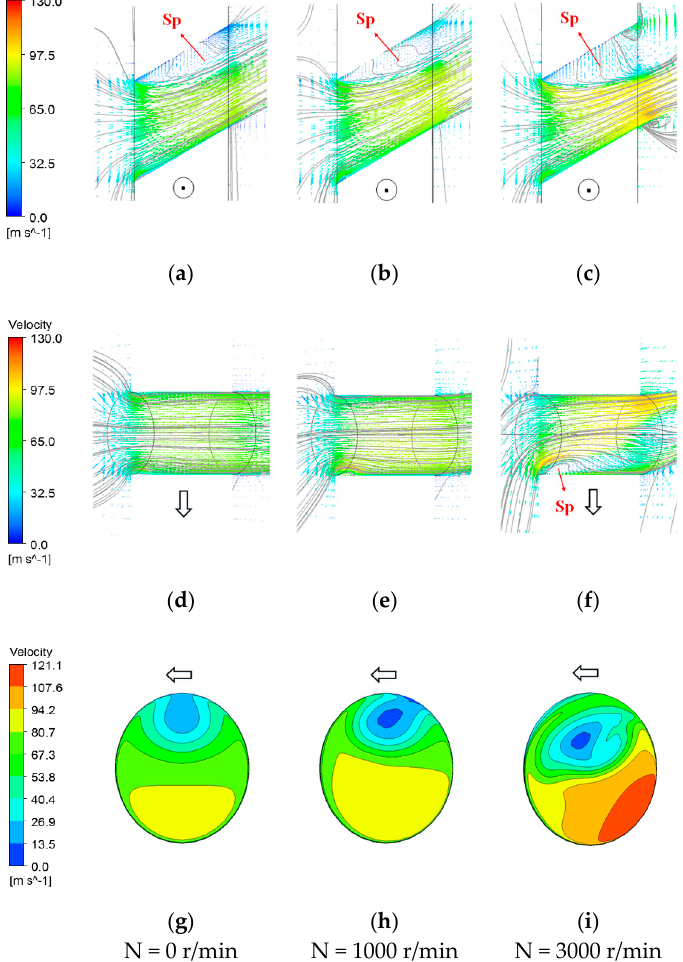
Figure 25. Streamlines and velocity contours of different sections ( 𝛼 (cid:2868) = 30°). ( a – c ) Meridian section; ( d – f ) circumferential cross-section; ( g – i ) velocity contour of the exit section. ( a , d , g ) 𝛼 (cid:2868) = 30°, i = − 26.7°, 𝐶 (cid:2914) = 0.732, ( b , e , h ) 𝛼 (cid:2868) = 30°, i = − 25.4°, 𝐶 (cid:2914) = 0.751, ( c , f , i ) 𝛼 (cid:2868) = 30°, i = − 33.9°, 𝐶 (cid:2914) = 0.672.